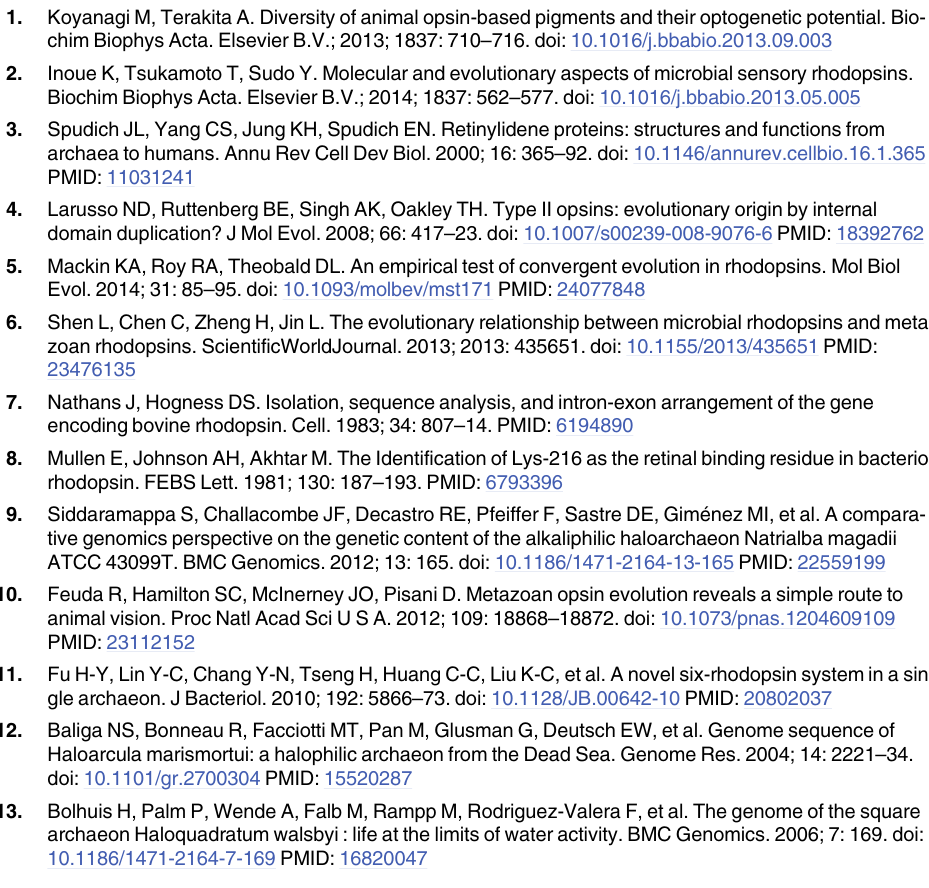
S3 Table. Primer sequences. PCR and cloning primers for ORPs from four species used in experimental confirmation of ORP expression. Expected product lengths and primer set